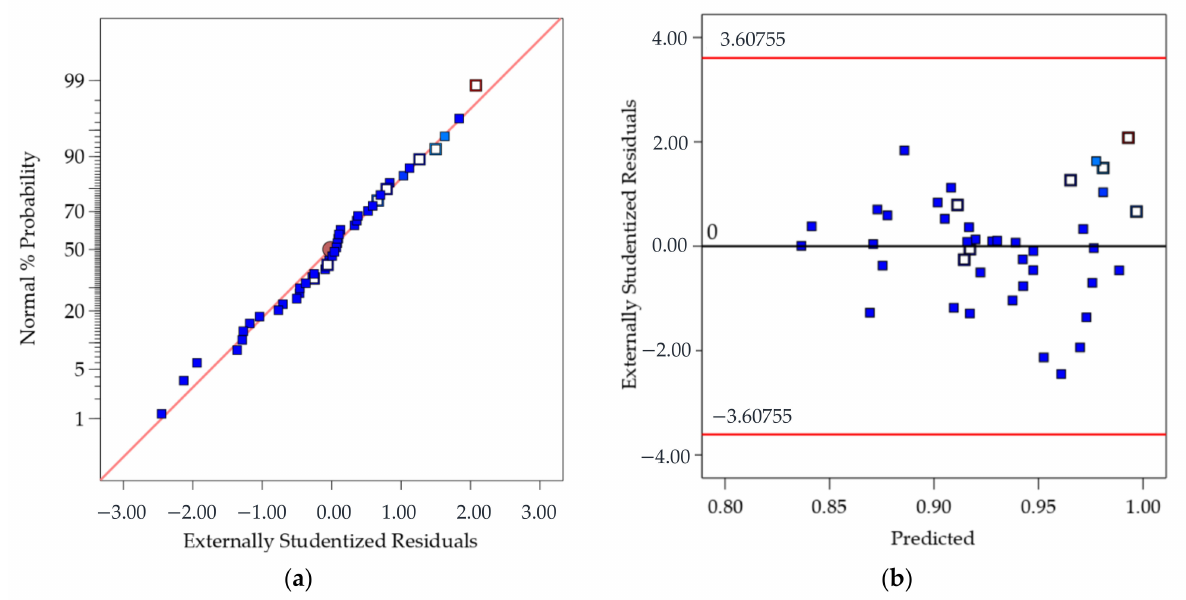
Figure 2. ( a ) Normal probability plot of the studentized residuals to check for normality of residuals (the approximately linear plot allows to assume that the error/residual terms are normally distributed, and the estimates/predicted values are unbiased or on average correct); and ( b ) Studentized residuals versus predicted values to check for constant variation (a random distribution should be expected and so the model predicts values higher and lower than the actual with equal probability).